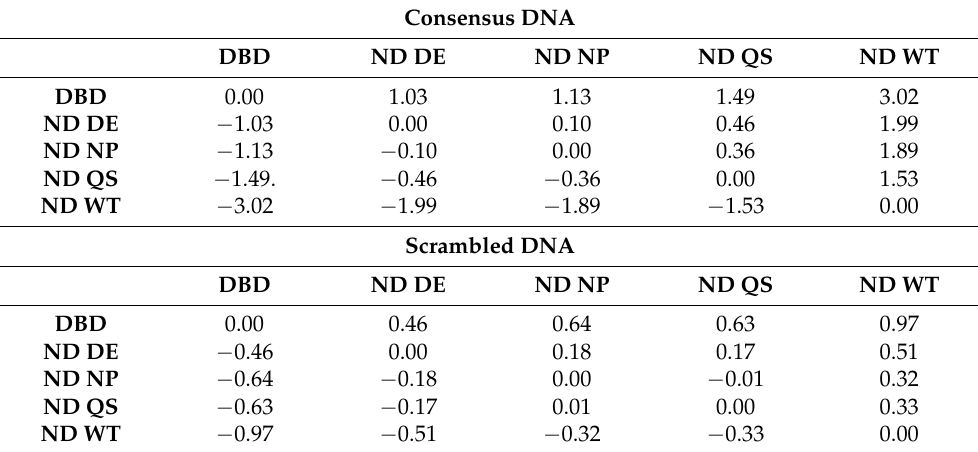
Table 1. ∆∆ G (column-row) in kcal/mol at physiological